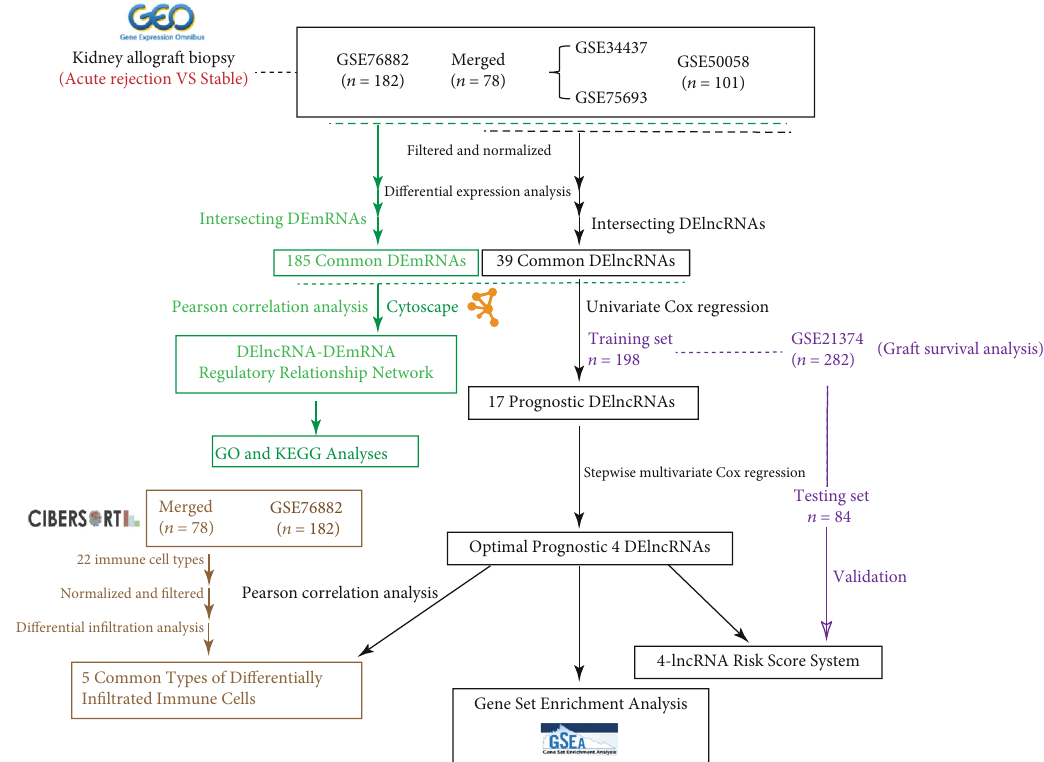
Figure 1: Flowchart of our study